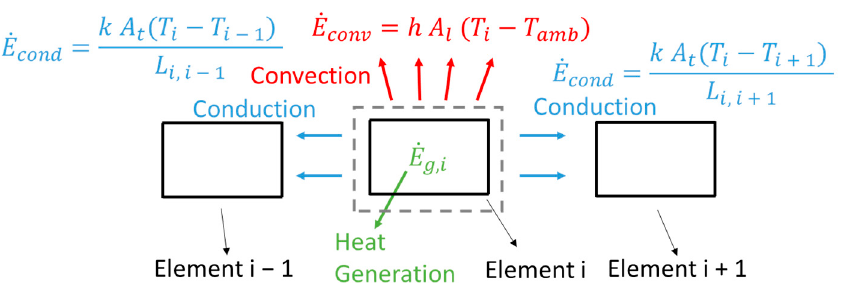
Figure 5. Energy balance for one element, where k is the thermal conductivity, h is the convection coefficient, L is the distance between the centers of two adjacent elements, A t is the cross-section area, A l is the surface area, and T amb is the ambient temperature.